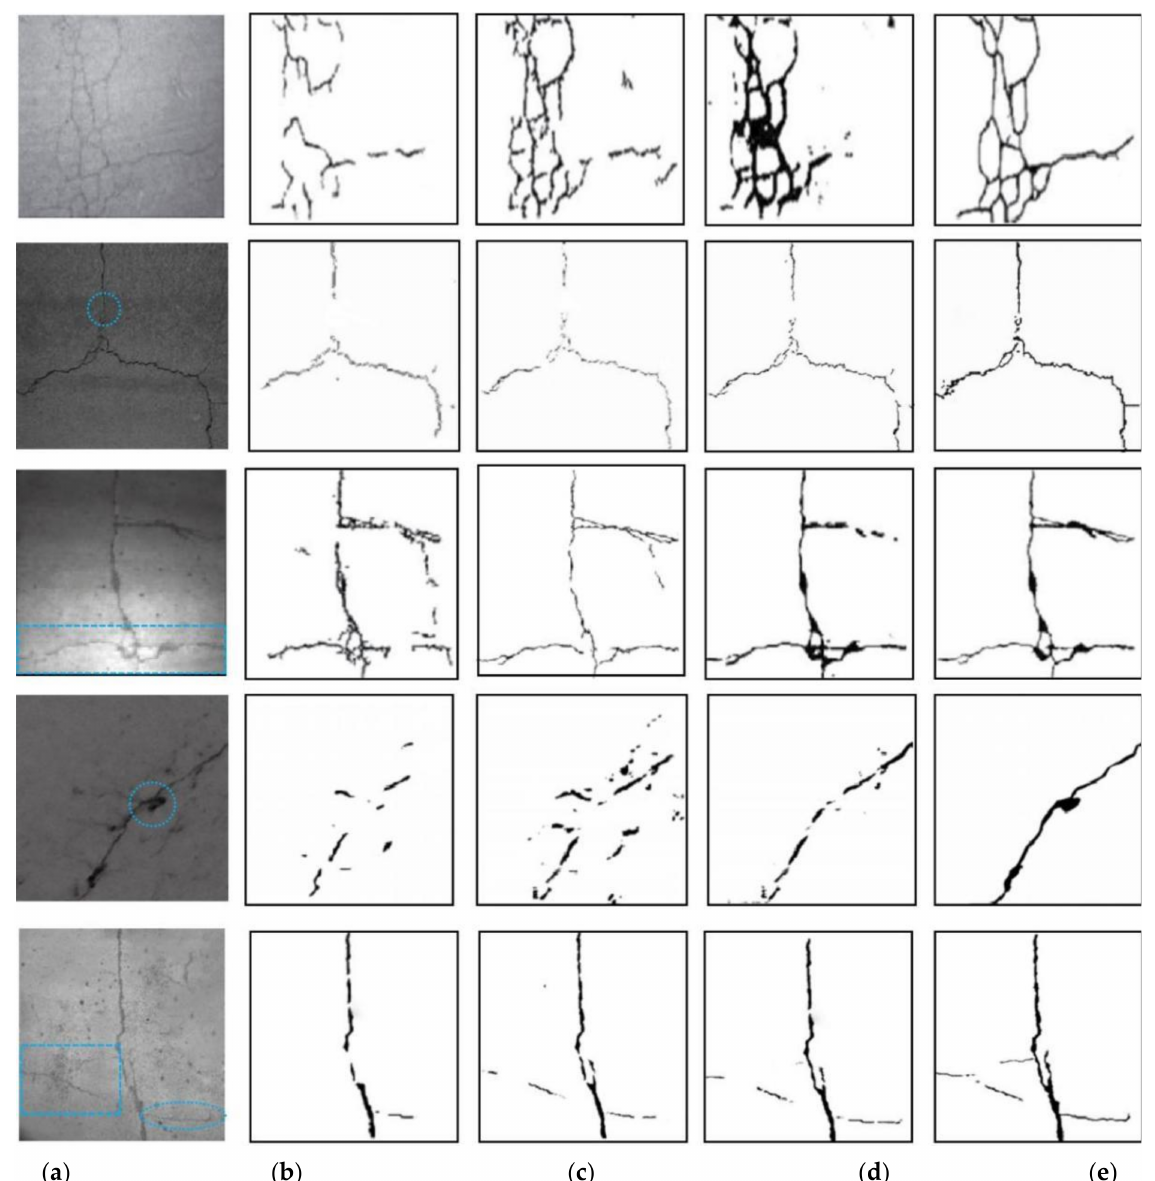
Figure 10. Segmentation results of the crack by four networks, ( a ) is the original crack images, ( b – e ) are the FCN, U-Net, YOLO v5, and proposed method,